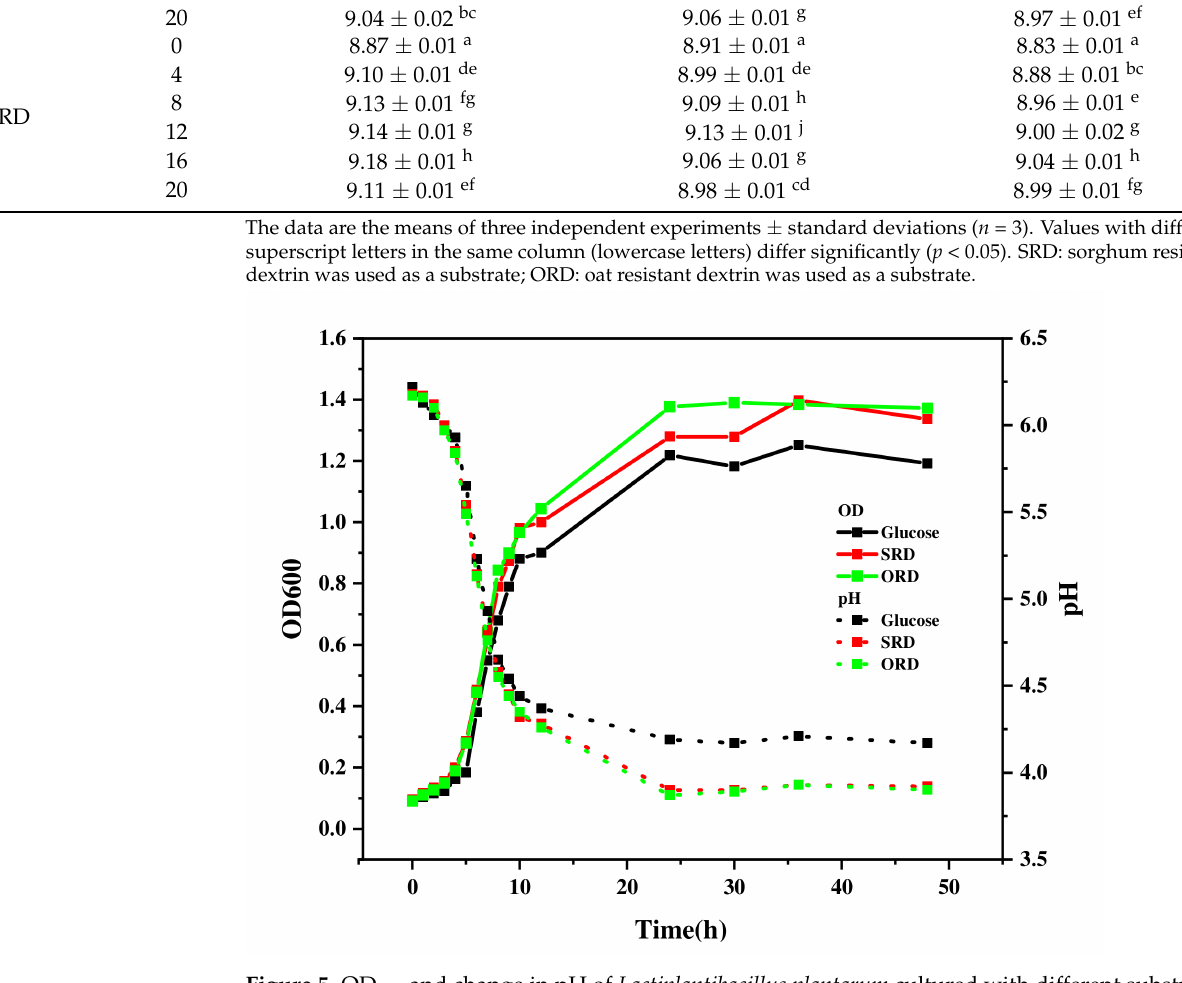
Figure 5. OD 600 and change in pH of Lactiplantibacillus plantarum cultured with different substrates. SRD: sorghum resistant dextrin was used as a substrate; ORD: oat resistant dextrin was used as a substrate; glucose: control